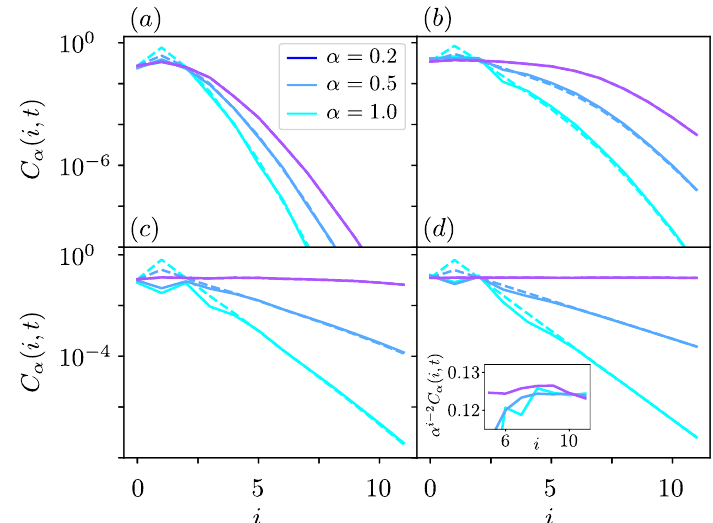
Figure 7: Fixed time α -OTOCs C α ( i , t ) ( L = 12), numerical results (solid) and their predicted scaling Eq. (11) from the Hilbert space fragments (dashed lines) at time t = 1.0 (a), t = 3.0 (b), t = 7.0 (c) and t = 30.0 (d). Inset: The same Otoc, now rescaled by α i − 2